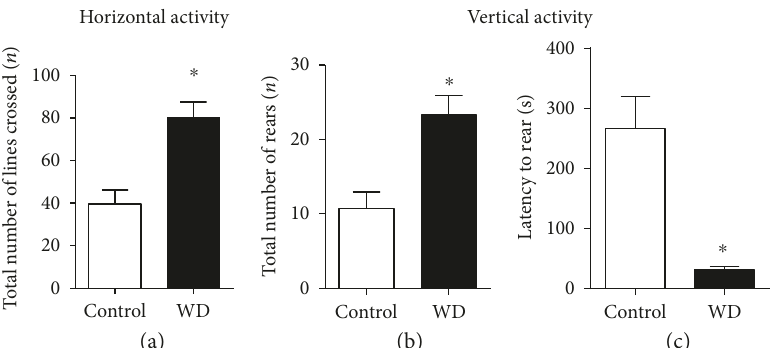
Figure 4: The cholesterol-enriched diet enhances horizontal and vertical activity during food competition test. In comparison to control mice, animals exposed to the cholesterol-enriched diet showed (a) a signi fi cant increase in the total number of line crossing ( ∗ p < 0 05 versus that in the control group, t -test), (b) signi fi cant elevation of the total number of rearings ( ∗ p < 0 05 versus that in the control group, Mann-Whitney test), (c) and a signi fi cant decrease in the latency of rearings ( ∗ p < 0 05 versus that in the control group, t -test). Control — standard diet, WD — high-cholesterol diet. Data are shown as mean ± SEM (a, c) and median with interquartile range